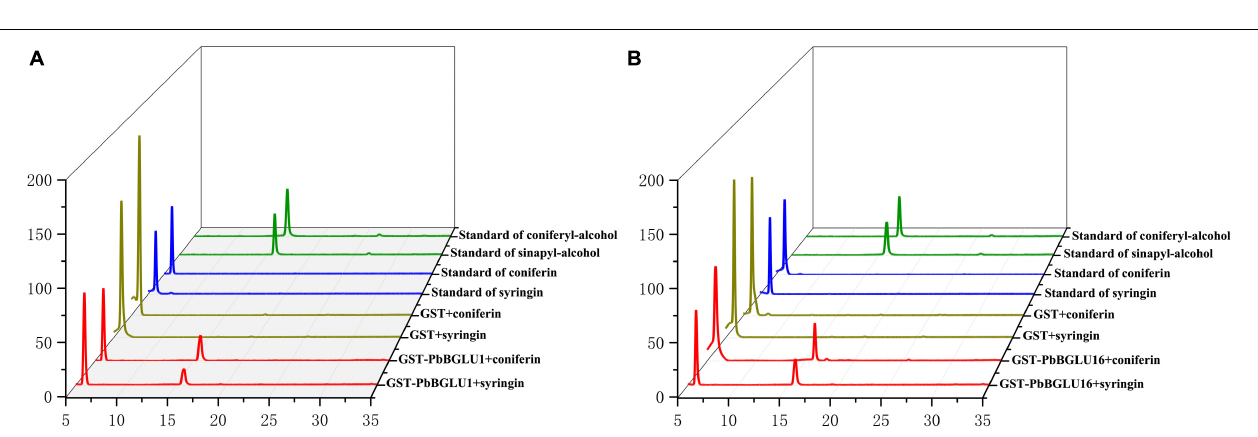
FIGURE 5 | RNA in situ hybridization illustrating PbBGLU1 and PbBGLU16 transcript localization in 39 DAF (day after flower) pear fruit. (A,B) PbBGLU1 RNA in situ hybridization in 39 DAF (day after flower) pear fruit. (C,D) PbBGLU16 RNA in situ hybridization in 39 DAF (day after flower) pear fruit; Sections were taken through the flesh and probed with anti-sense (A,C) and sense probes (B,D) and imaged at 10 magnification. The positive expression of BCIP/NBT was blue-purple; the sense probes is for negative control; the bar = 100 µ m; SC, stone cells.